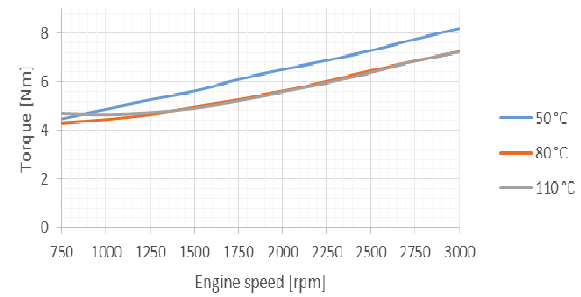
Fig. 7. The plot of averaged torque results for the five series of measure- ments as a function of oil temperature On the basis of the results it can be seen that the magni- tude of friction loss is higher for higher speeds of the en- gine.